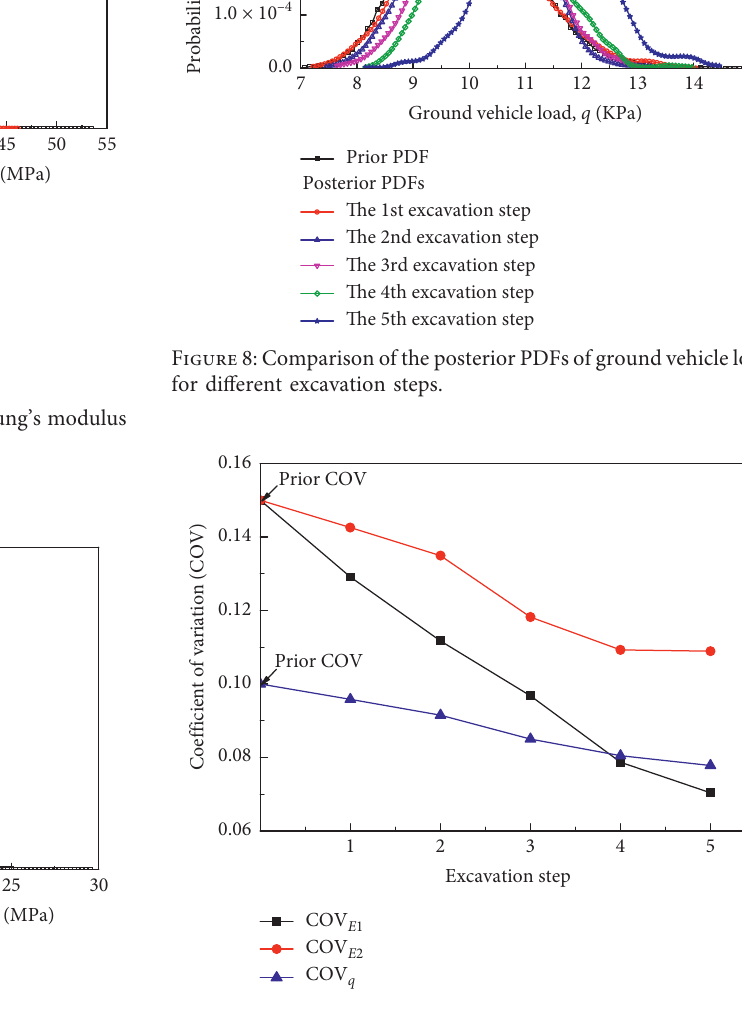
Figure 9: Variation of the coefficients of variation of input pa- rameters with the excavation